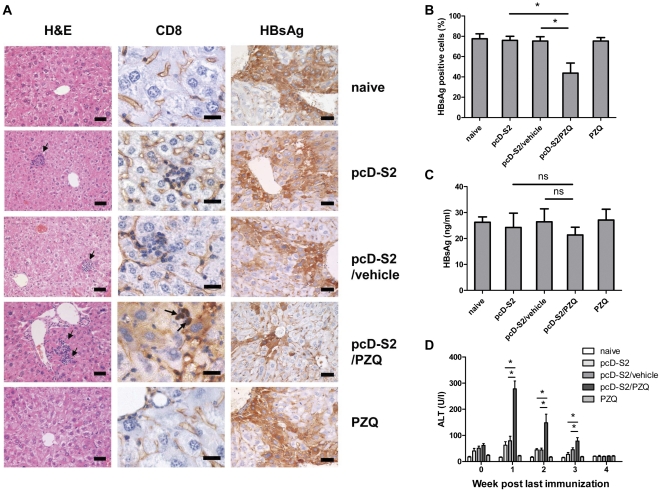
Histopathology of the liver and serology assays.A: livers from each group were obtained on day 14 after the third immunization and fixed, sectioned, and stained with H&E. Bar, 50 µm. CD8-specific immunostaining of the liver from HBsAg transgenic mice on day 14 after final immunization. Bar, 20 µm. Specific immunostaining of HBsAg on day 14 after final immunization. Bar, 50 µm. B: Percentage of HBsAg-positive liver cells in indicated groups on day 14 after final immunization. C: HBsAg antigen in the serum on day 14 after final immunization. D: ALT activity in the serum on weeks 0, 1, 2, 3, and 4 after the third immunization. Results were representative of three independent experiments. There were four mice in each group (* p<0.05; ns, p>0.05).